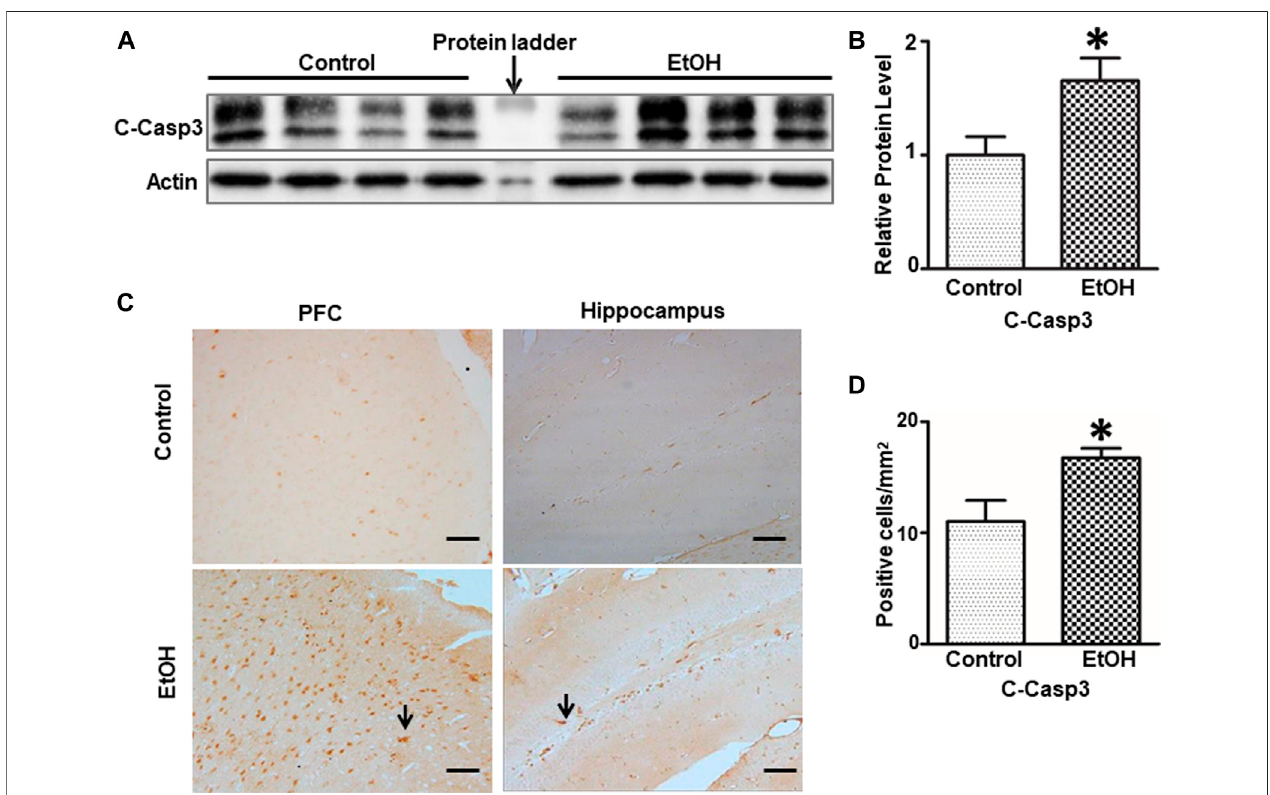
FIGURE 4 | Effects of chronic alcohol exposure on the expression of activated caspase-3. (A) The expression of cleaved caspase-3 in the cerebrum was determinedbyIB. (B) Therelativeamountsofexpressionwerequanti fi edandnormalizedtotheexpressionofactin.Theresultwasexpressedasthemean ± SEM;n (cid:2) 4. * p < 0.05denotesastatisticallysigni fi cantdifferencefromthecontrolgroup. (C) Theexpressionofcleavedcaspase-3intheprefrontalcortex(PFC)andthedentategyrus (DG)ofthehippocampuswasexaminedbyIHC;bar (cid:2) 50 μ m.Arrowsindicatecellsthatarepositiveforcleavedcaspase-3. (D) Thenumbersofcleavedcaspase3- positive cells in the hippocampus and PFC were determined. The results were expressed as the mean ± SEM; n (cid:2) 4.